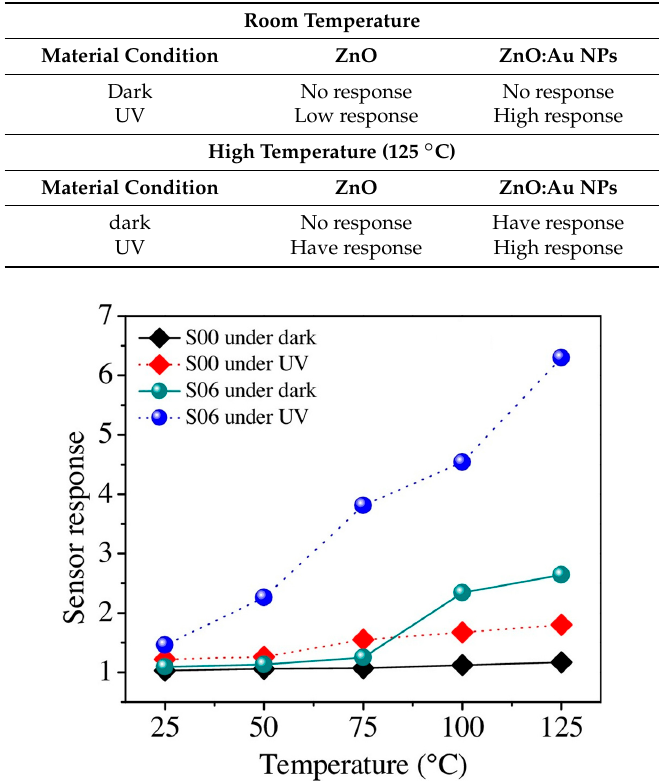
Table 4. Ethanol sensing results of pure ZnO and Au NPs decorated ZnO under different mearsurement conditions.